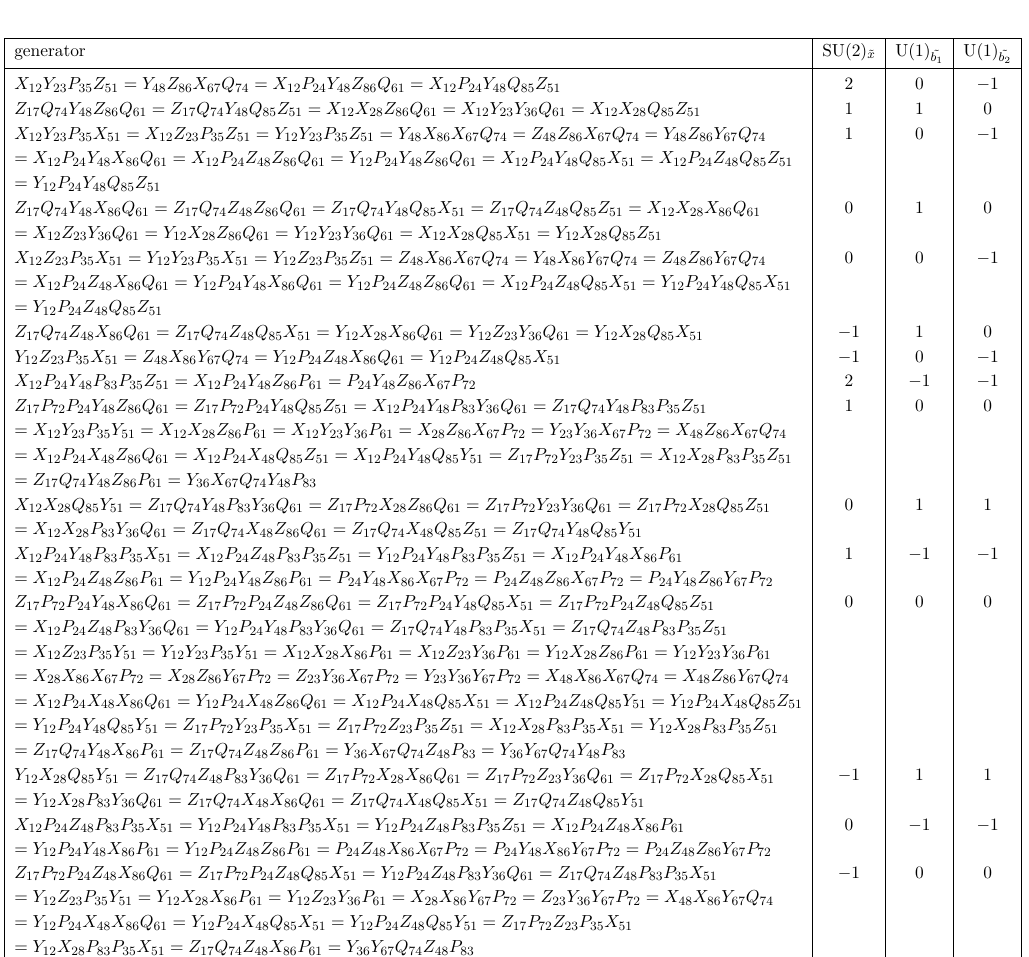
Table 29 . The generators in terms of bifundamental chiral fields for Model 7 (Part 1)